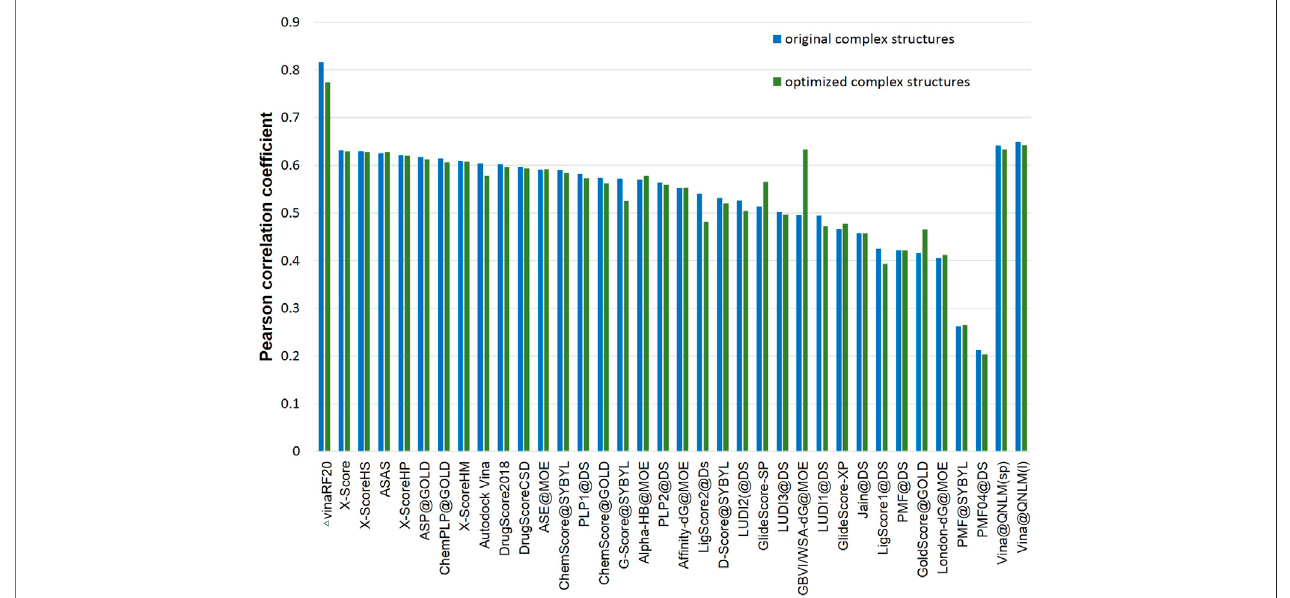
FIGURE7| ScoringpoweroforiginalcomplexstructuresandoptimizedcomplexstructuresandPearsoncorrelationcoef fi cientsofVina@QNLMinsingle-point(sp) and local (l) modes (blue and green bars), compared to the methods evaluated in CASF-2016 and recalculated.